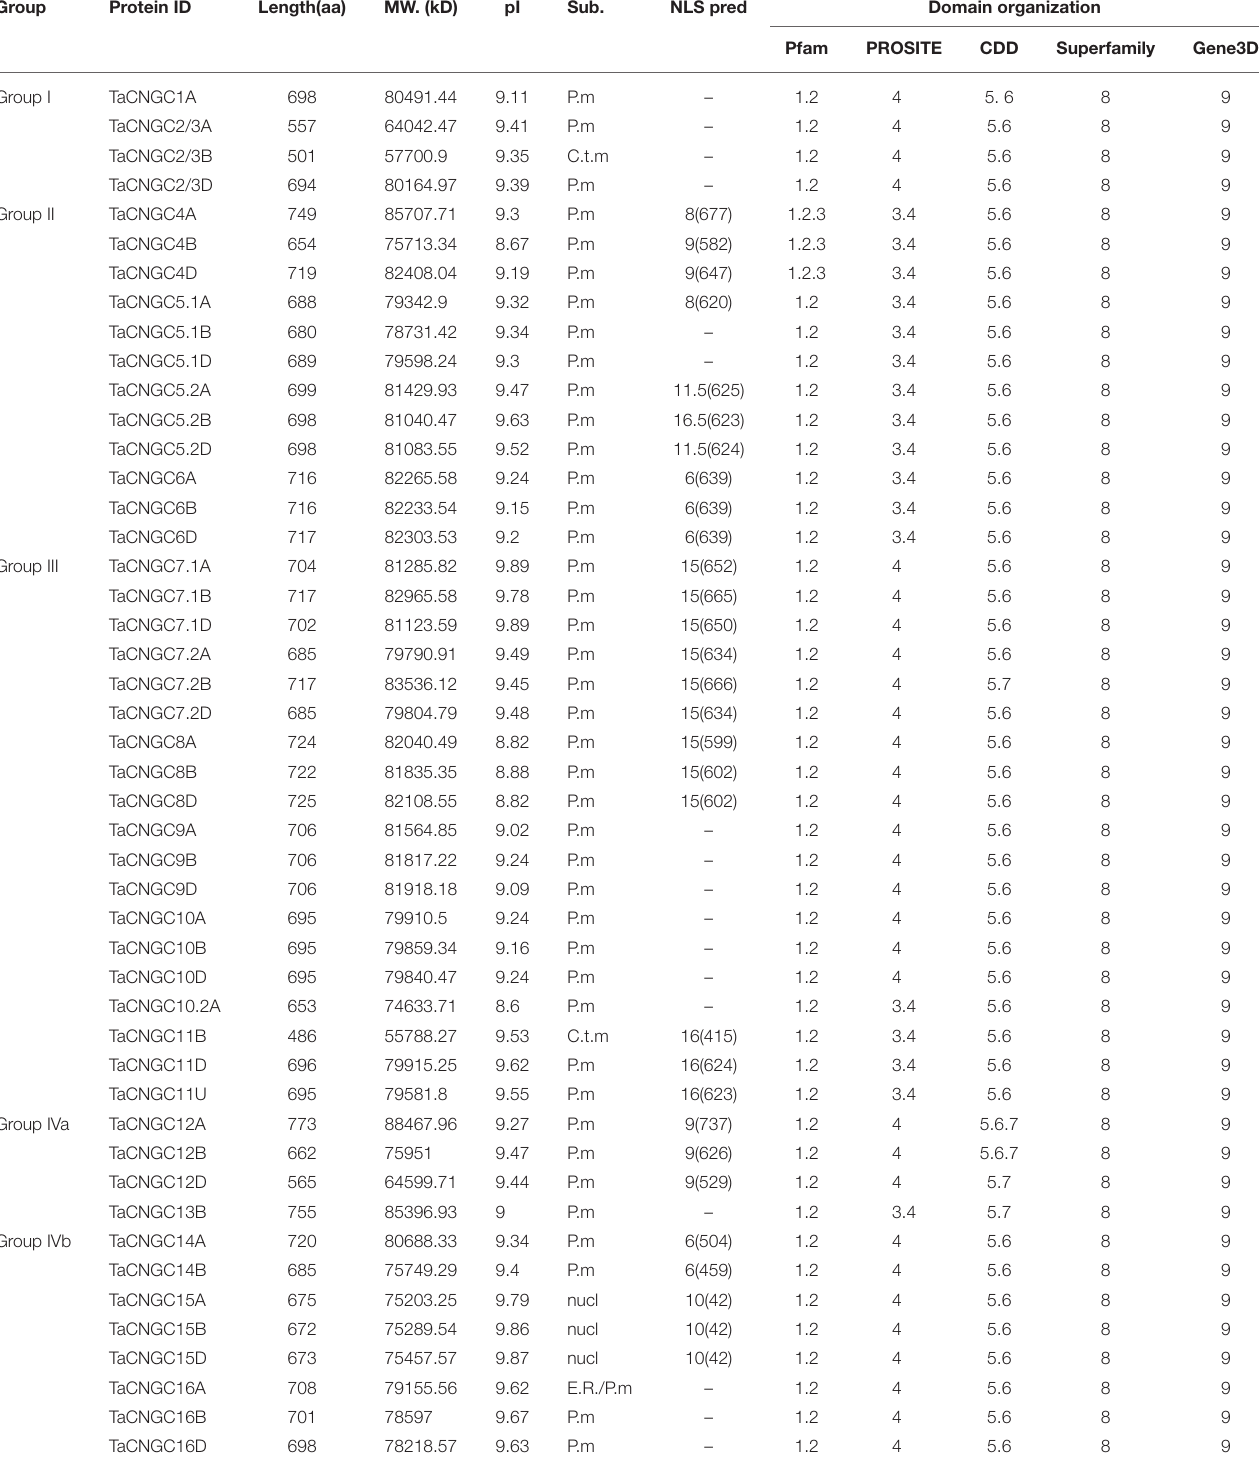
Pfam PROSITE CDD Superfamily Gene3D